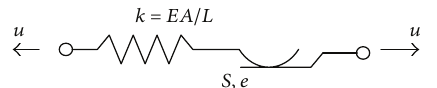
Figure 17: Mechanical model of a semiactive friction